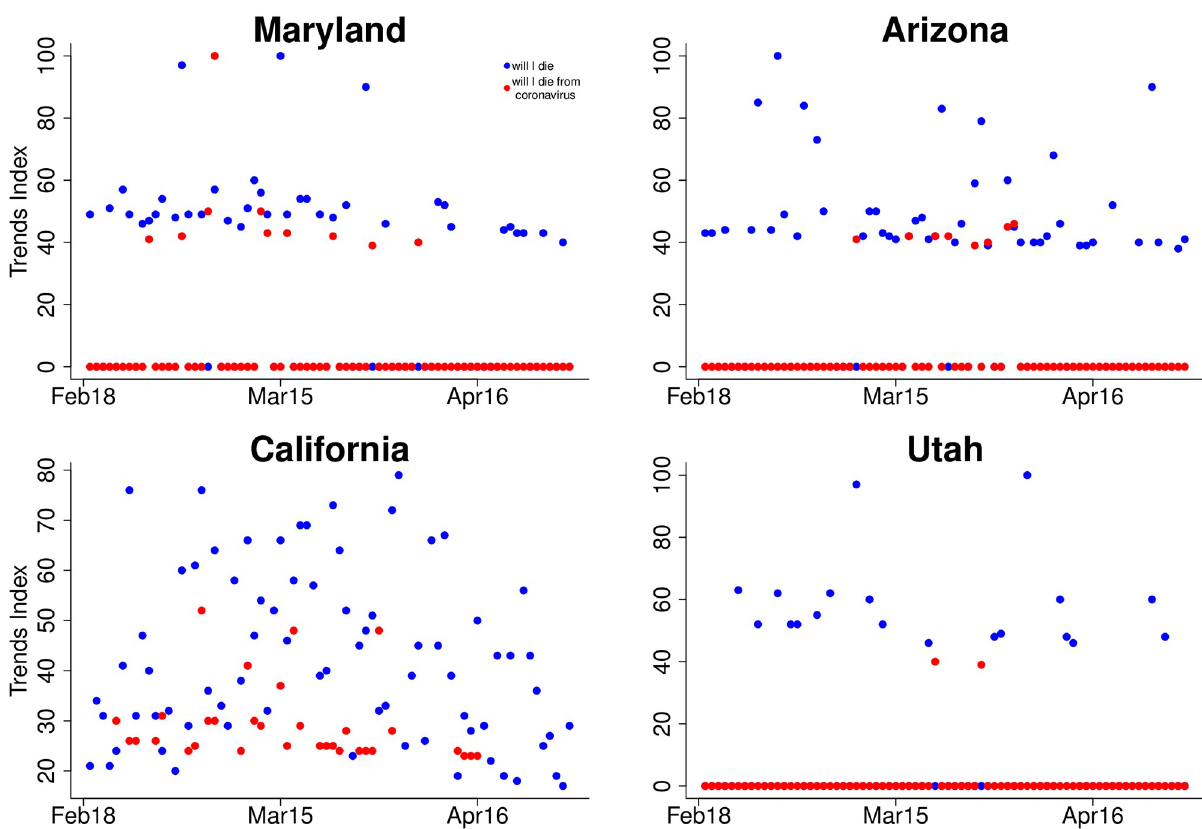
Fig 1. ‘will I die’ (blue) vs. ‘will I die from coronavirus’ (red). Same GT collection.